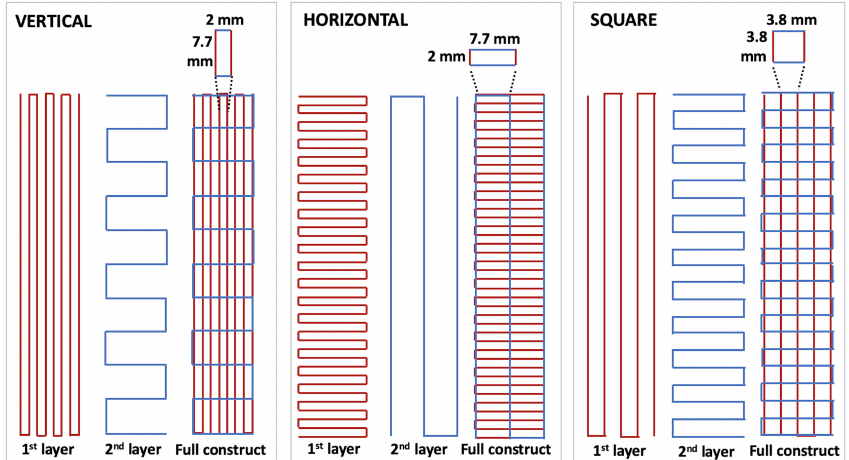
Figure 1. Representative images of the first two layers used for the fabrication of the 3D-printed membranes (10 layers total) with a vertical or horizontal orientation of the pores or membranes with square-shaped pores. For each orientation of the pores (vertical, horizontal, square), we show the distance between the filament used to create the